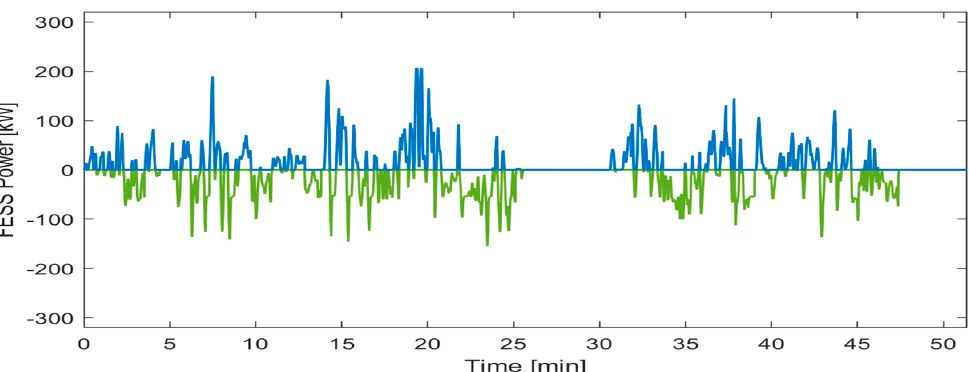
Figure 14. Power profile of the FESS bench.